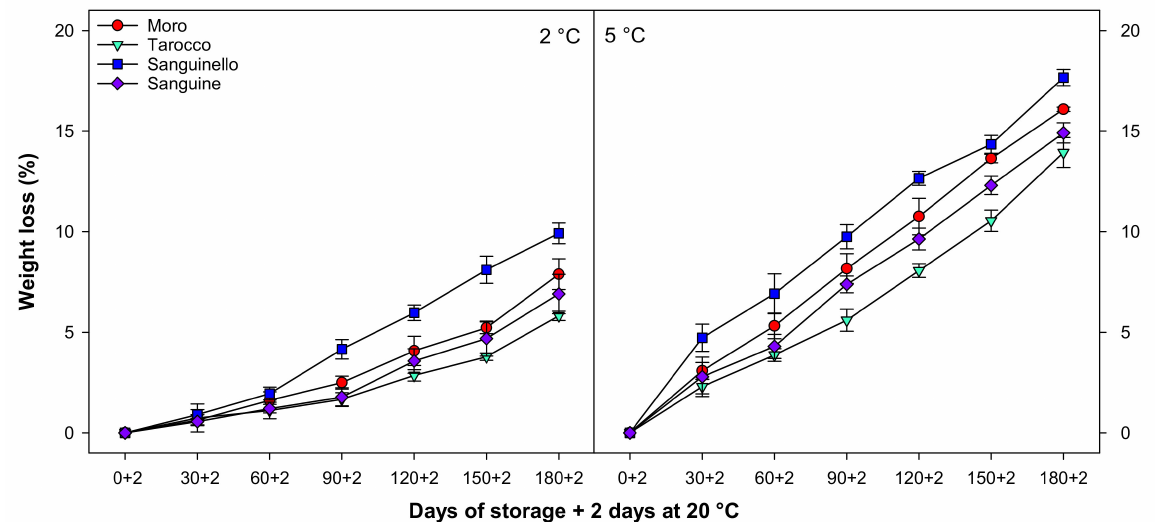
Figure 1. Changes in weight loss of blood orange cultivars (‘Moro’, ‘Tarocco’, ‘Sanguinello’, and ‘Sanguine’) during cold storage at 2 and 5 ◦ C and 90% relative humidity (RH) plus 2 days at 20 ◦ C. Vertical bars represent ± standard error (SE) of means. LSD ( p < 0.05) value is 0.95.